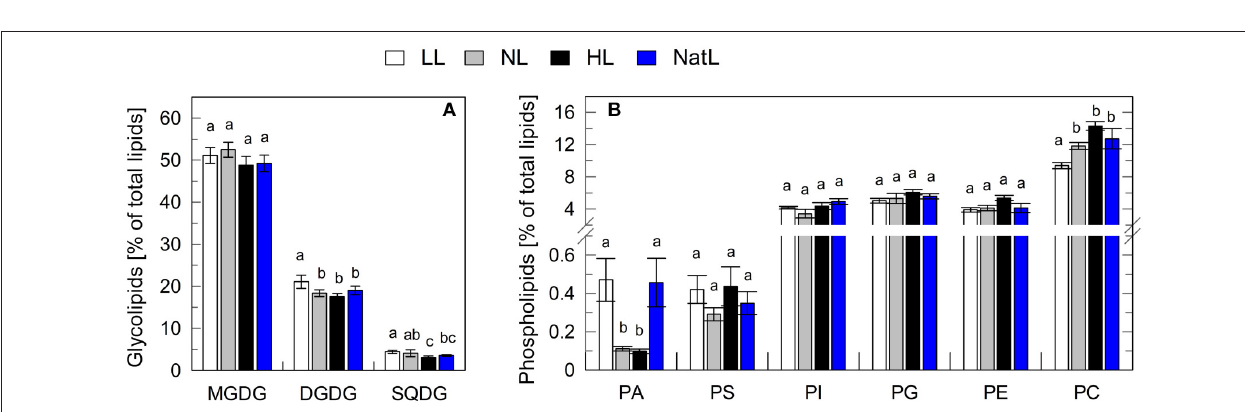
FIGURE 4 | Lipid composition of leaves. (A) Relative amount of glycolipids. (B) Relative amount of phospholipids. MGDG, Monogalactosyldiacylglycerol; DGDG, Digalactosyldiacylglycerol; SQDG, Sulfoquinovosyldiacylglycerol; PA, Phosphatidic acid; PS, Phosphatidylserine; PI, Phosphatidylinositol; PG, phosphatidylglycerol; PE, and phosphatidylethanolamine; PC, Phosphatidylcholine. Mean values ± SD of five independent samples are shown. Significant differences [Holm-Sidak test, p < 0.05, for (A) ; Dunn’s test, p < 0.05, for (B) ] are